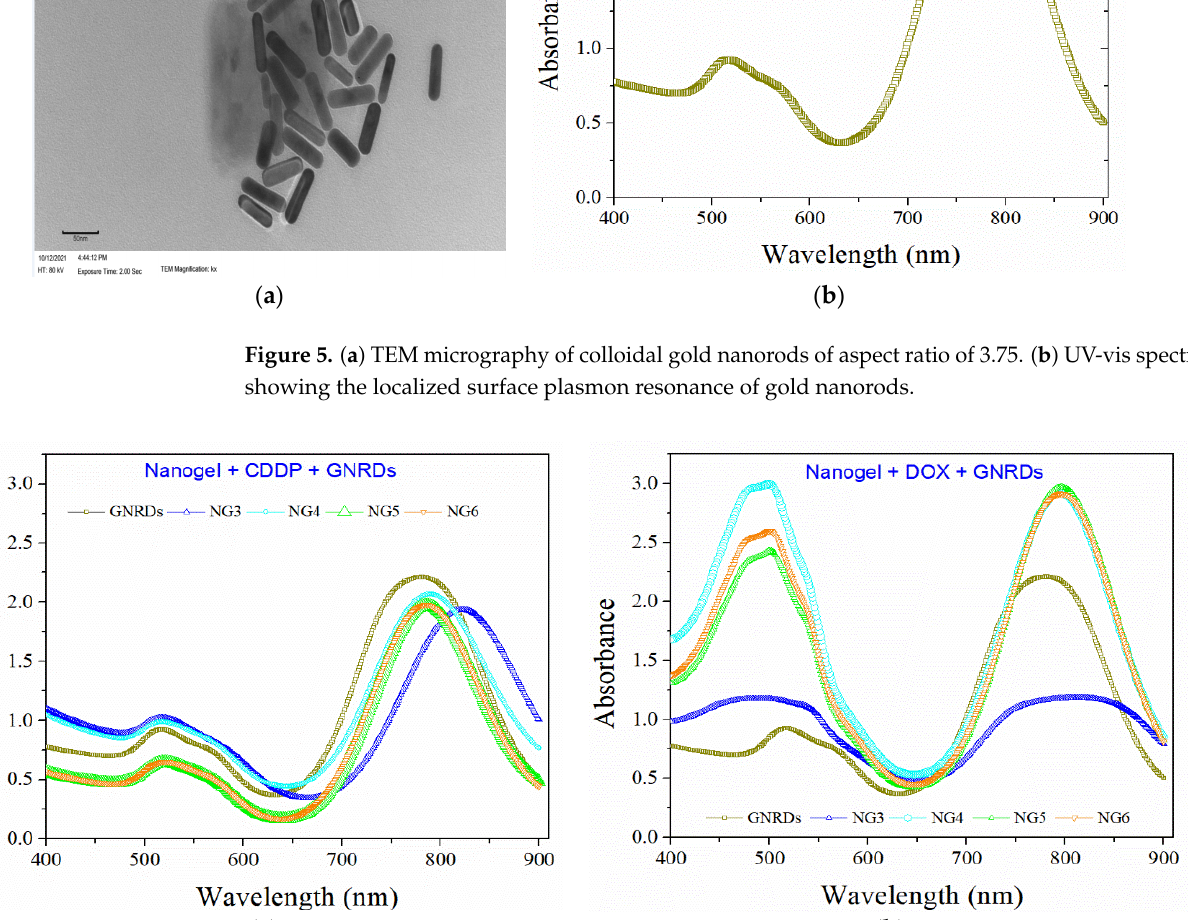
Figure 7. Size distribution by intensity of GNRDs encapsulated into PNVCL-based nanogels. To confirm the GNRDs’ photothermal effect, a 785 nm laser was used to irradiate the samples (Figure 8). The measurement consisted of irradiating the sample for 10 min; dur- ing this time, the temperature data was recorded every 2 s. The efficacy of photothermal analysis is based on the intense electromagnetic fields associated with the metal surface, which convert the energy from absorbed radiation into heat, resulting in irreparable cell damage. For these measurements, first distilled water was irradiated, showing no increase in temperature. Then, the GNRDs dispersed in distilled water were irradiated, showing a huge temperature increase of 26 °C; that is, going from 25 to 51 °C. Likewise, 1 mg/mL dispersions of nanogels loaded with GNRDs were irradiated under the same conditions.